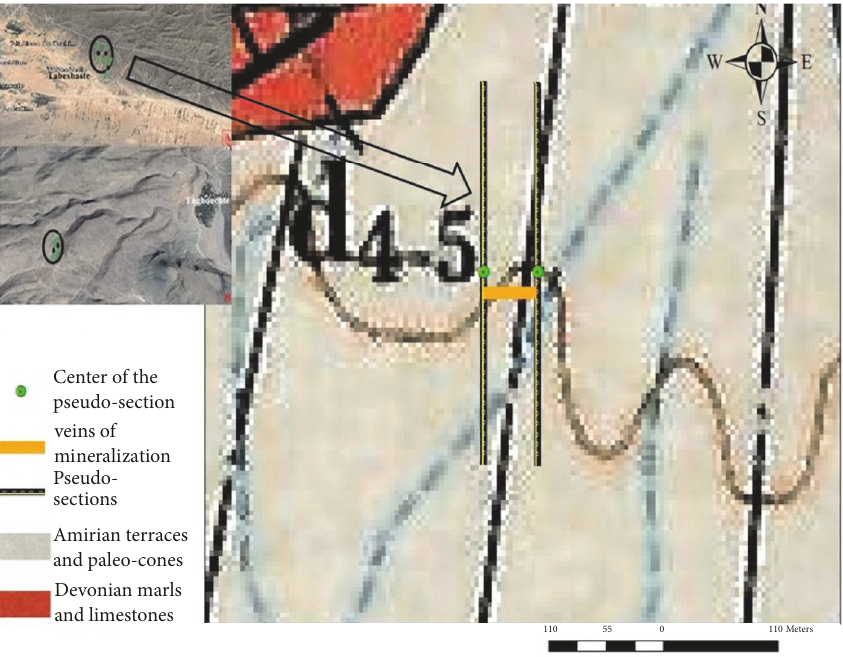
Figure 14: Map of correlation of the Galena veins obtained by pseudosections 3 and 5 (extracted from the Morocco Taghazout geological map